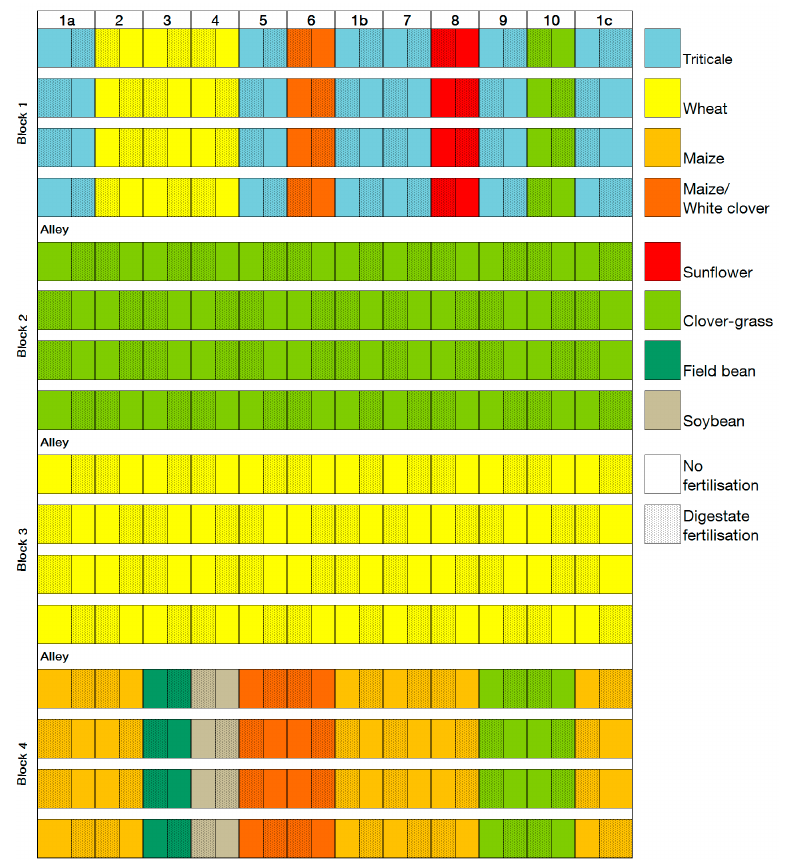
Figure 1. Field trial plot plan 2017. For dimensions see text. Crop rotations are indicated in the top row. top